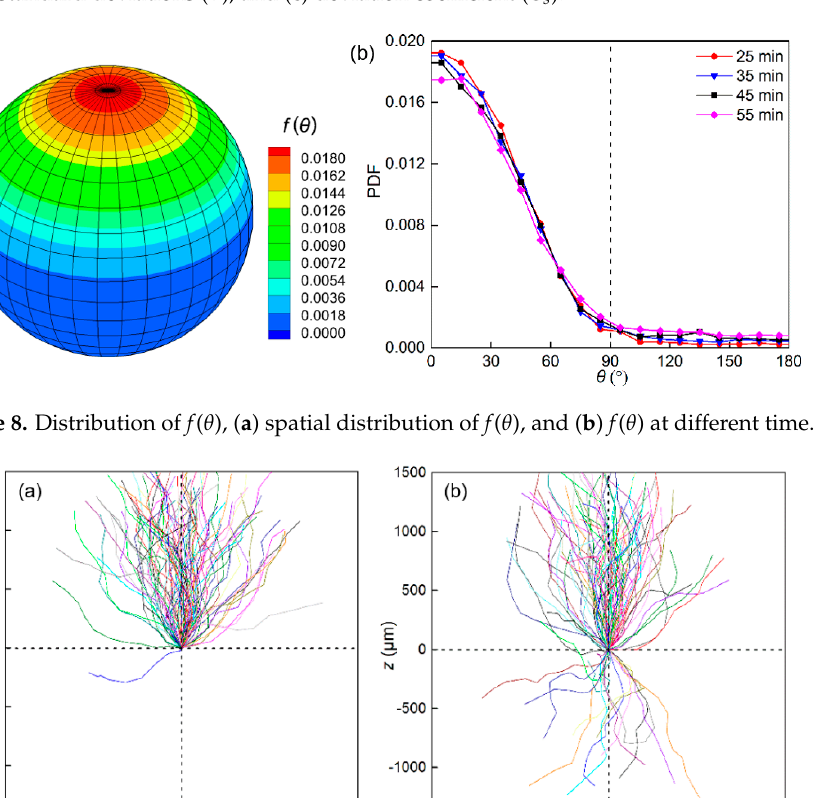
Figure 8. Distribution of f ( θ ), ( a ) spatial distribution of f ( θ ), and ( b ) f ( θ ) at different time.